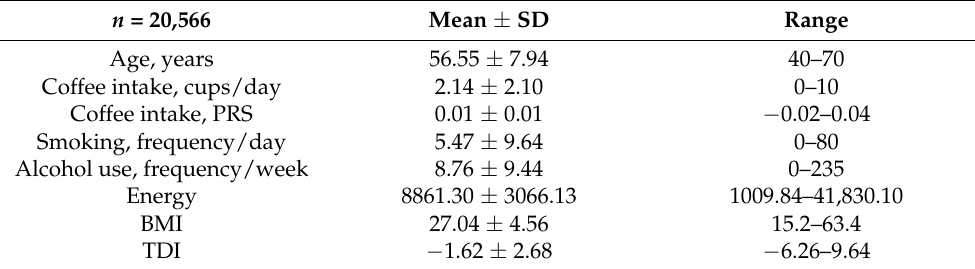
Table 1. Basic characteristics of study